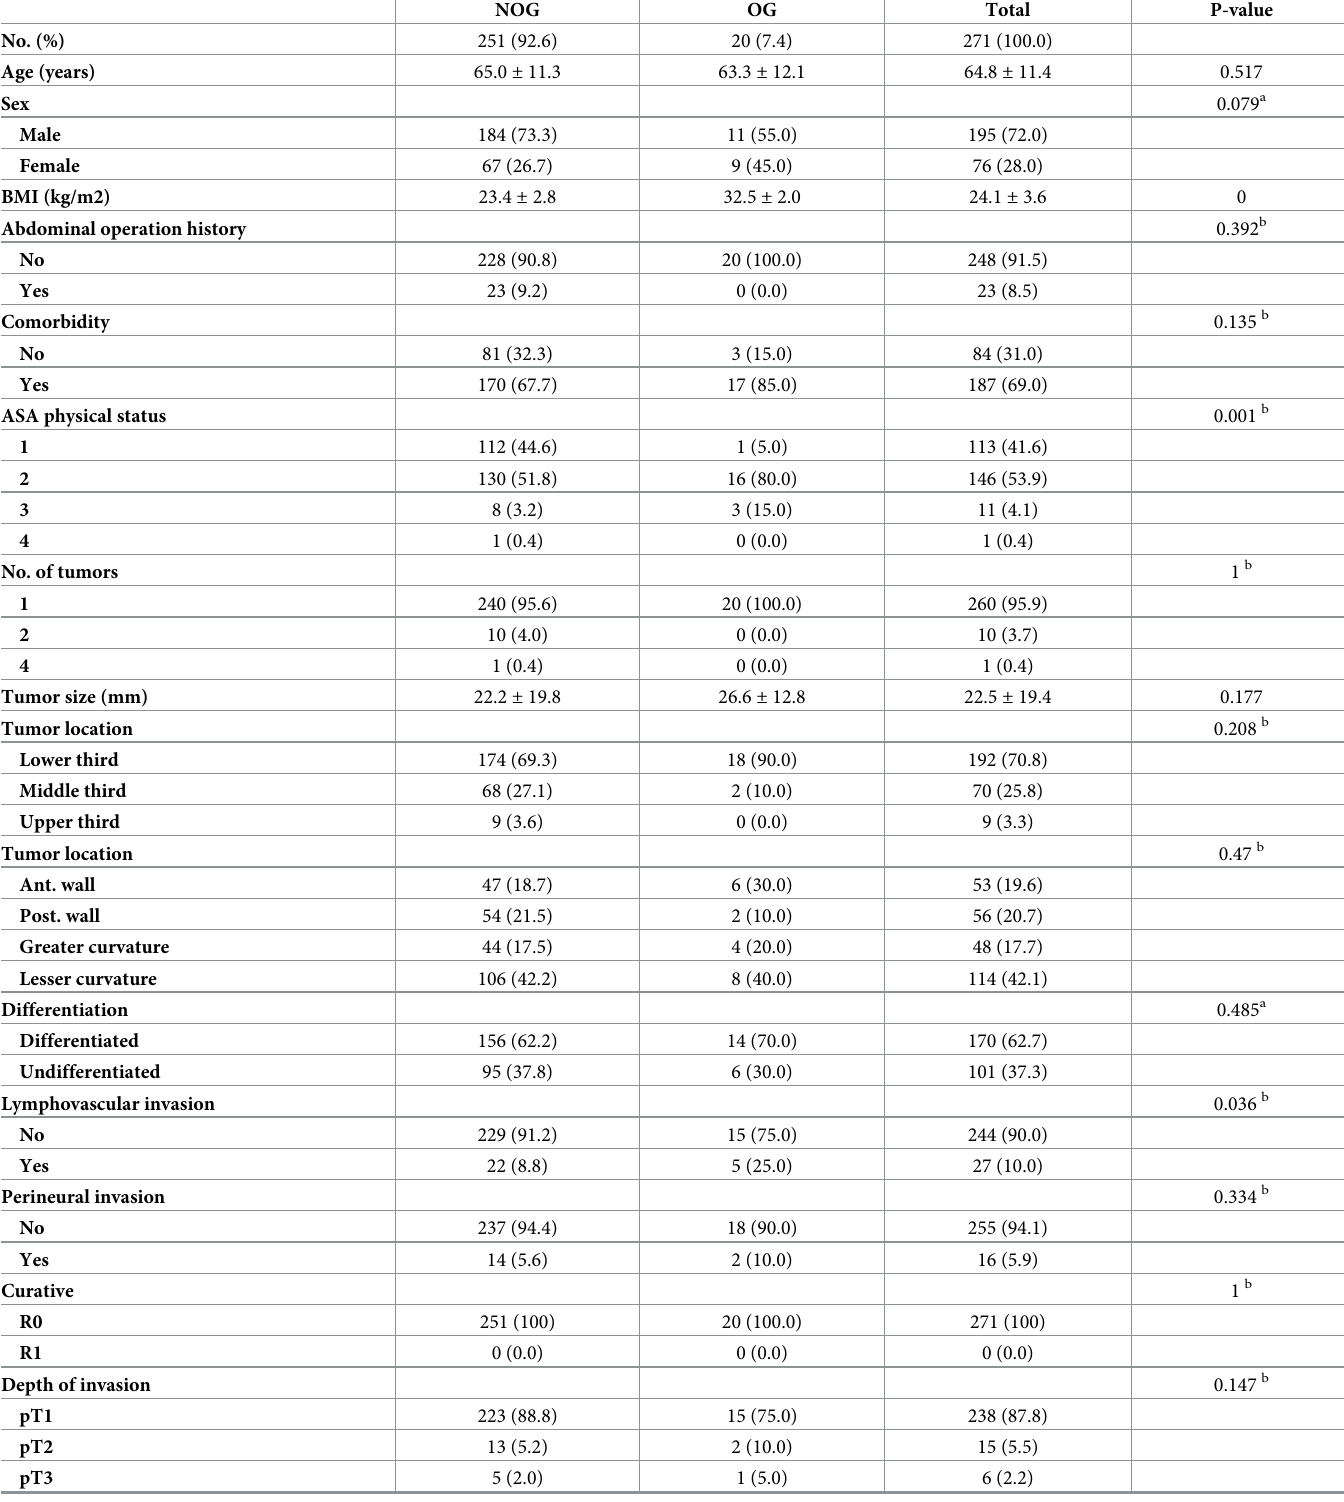
Table 1. Patient